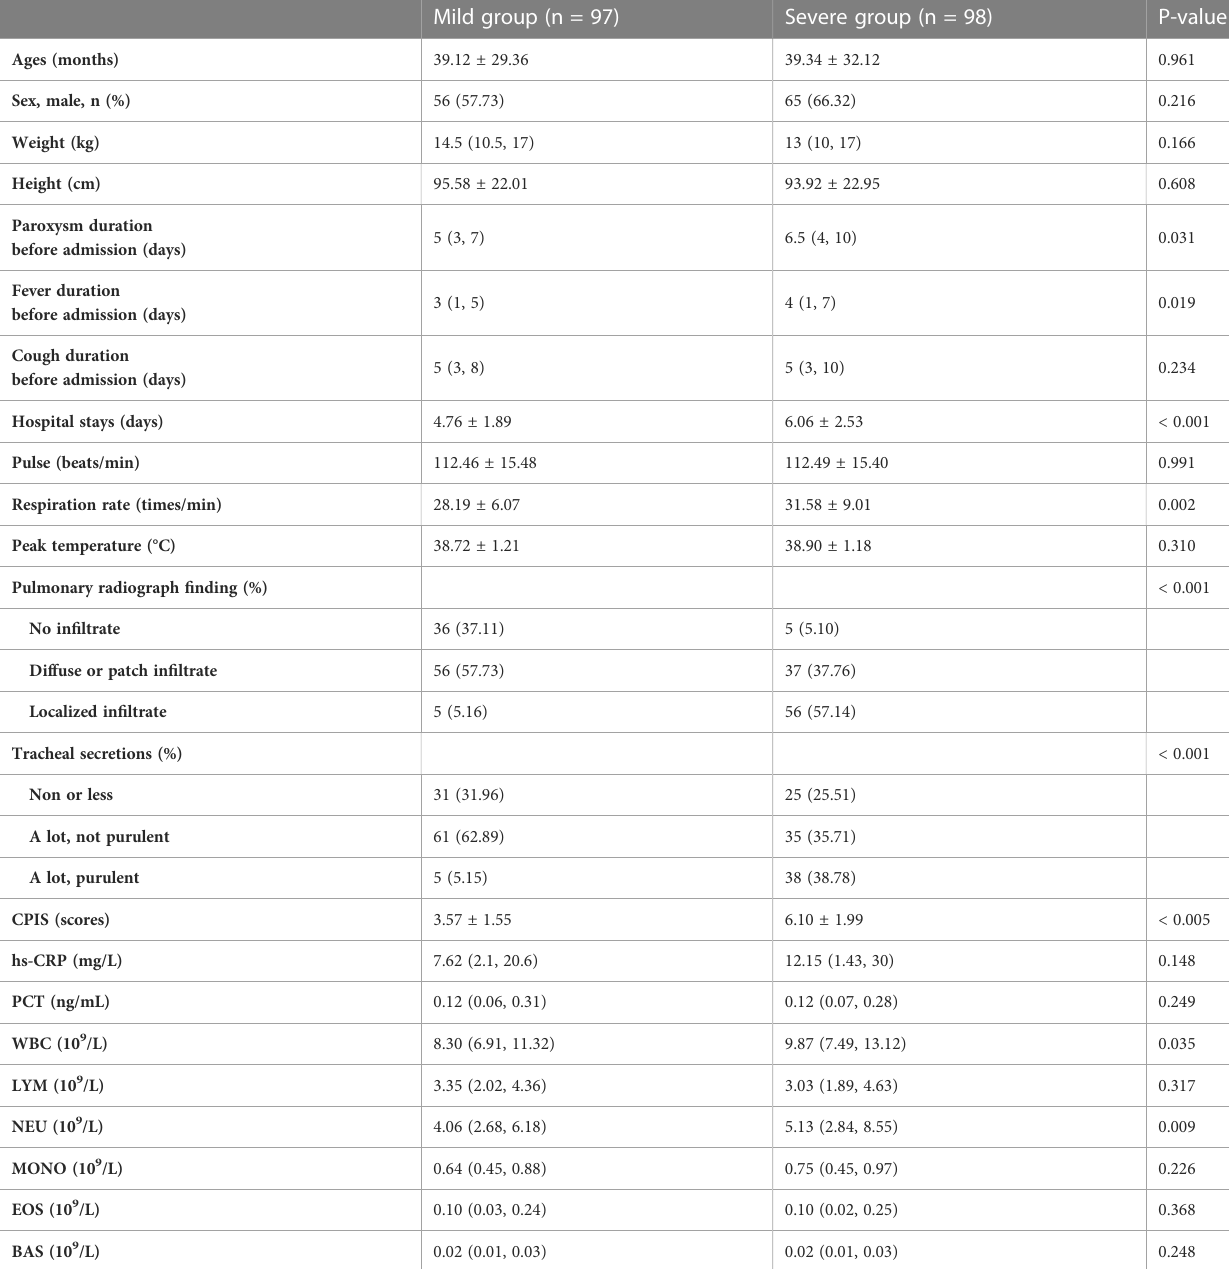
TABLE 3 The clinical and laboratory characteristics of the mild and severe group of children with